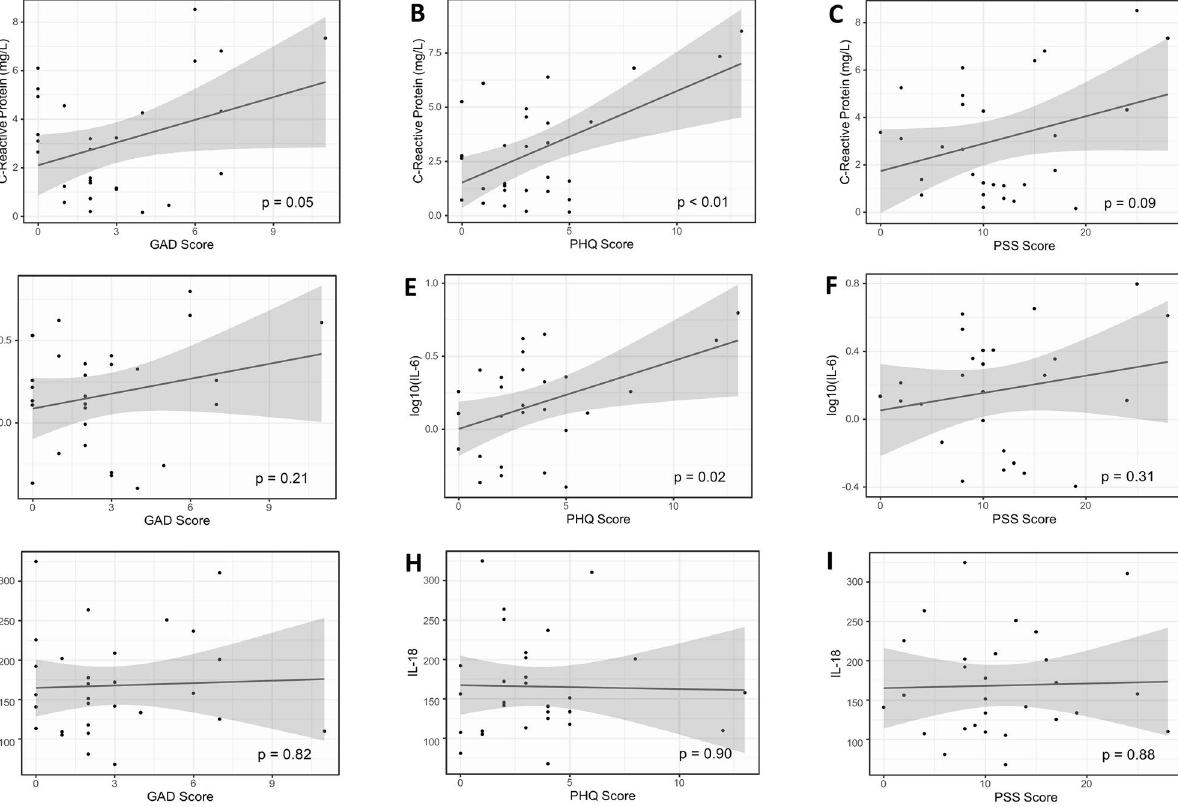
Figure 1. Associations between psychosocial stress scores and inflammatory marker